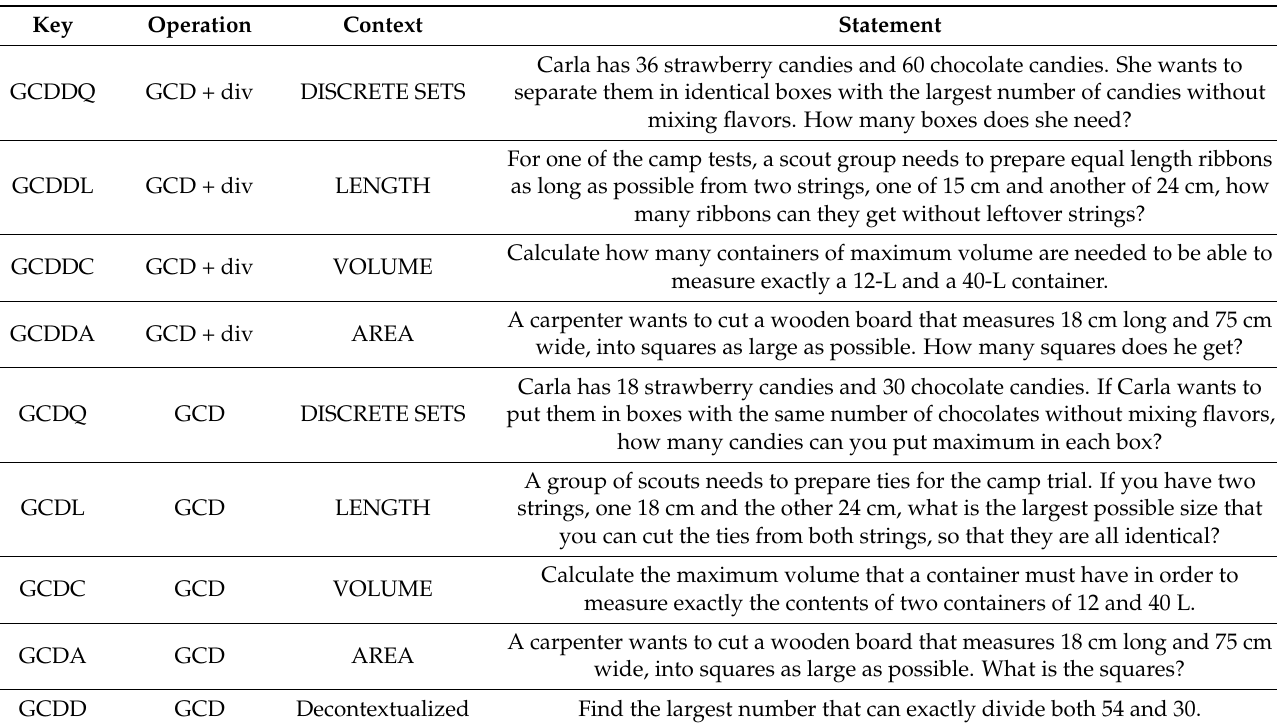
Table 1. Word problems from the written